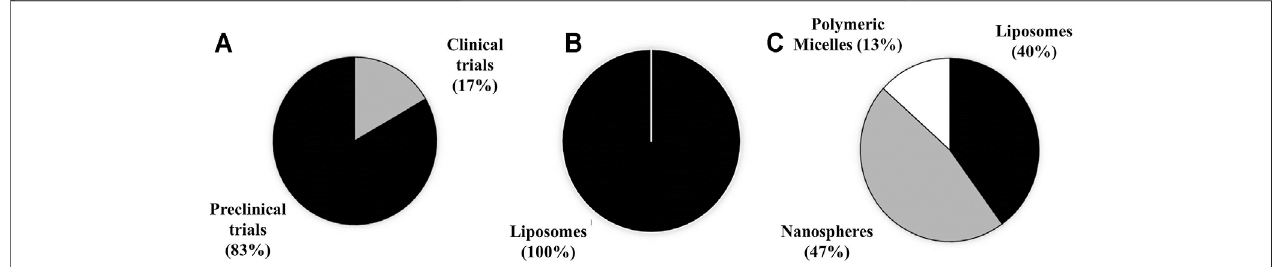
FIGURE 3 | Research recapitulation of (A) clincial and preclinical studies, (B) types of nanoparticle use in clinical trials, (C) and pre-clinical trials.